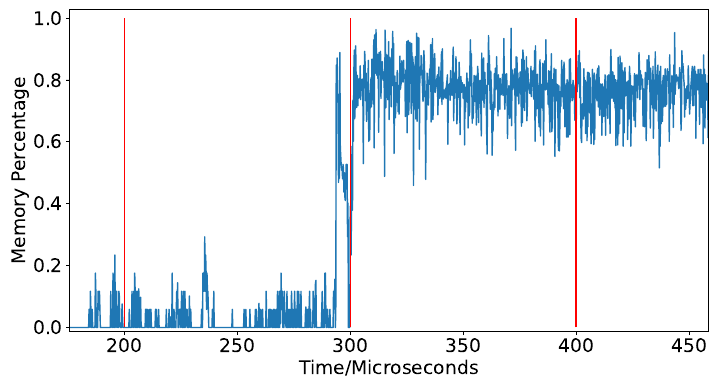
Figure 1. A running fragment of 605.mcf